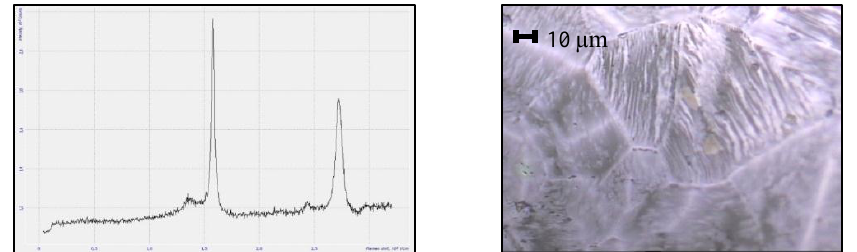
Fig. 1. Test sample SAG: а - Raman peak at 3-5 layers; б - the structure of multilayer graphene.